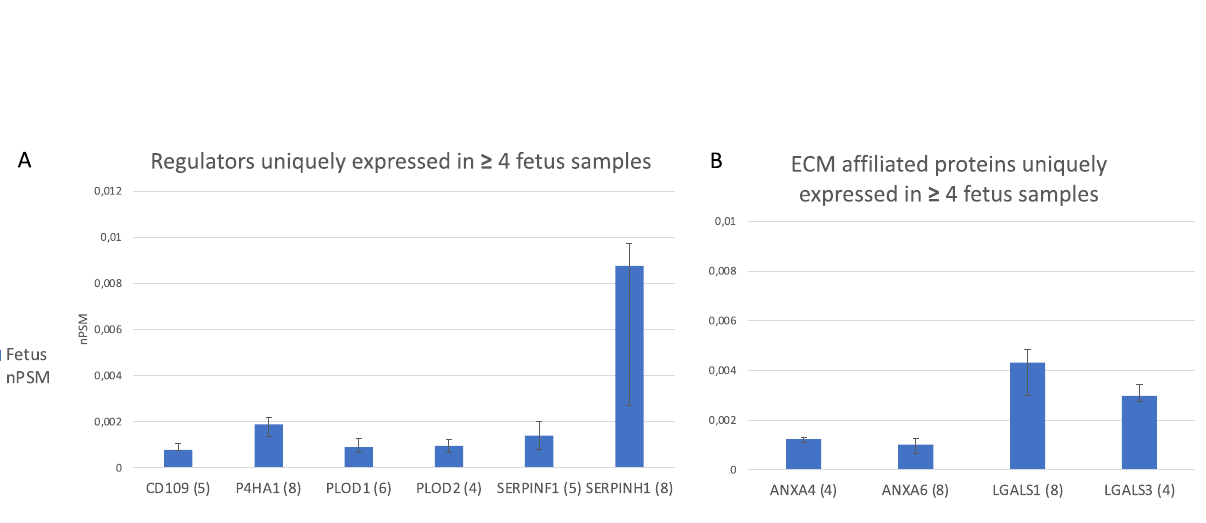
Figure 2. Uniquely expressed proteins. Proteins that were uniquely expressed in fetal NP’s. The Y-axis displays median normalized PSM’s per group, X-axis shows protein gene symbols and the (number of samples) expressing the protein. ( A ) Displays regulators, ( B ) ECM affiliated